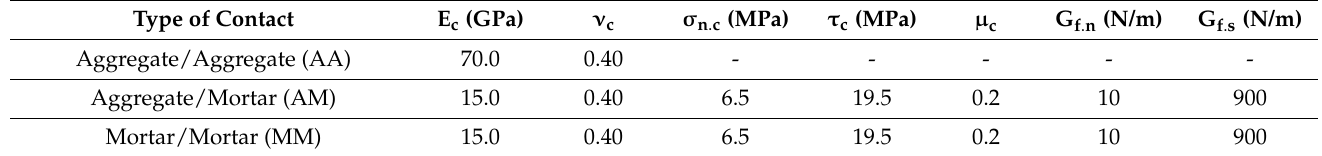
Table 1. Contact elastic and strength properties for uniaxial compression and tensile